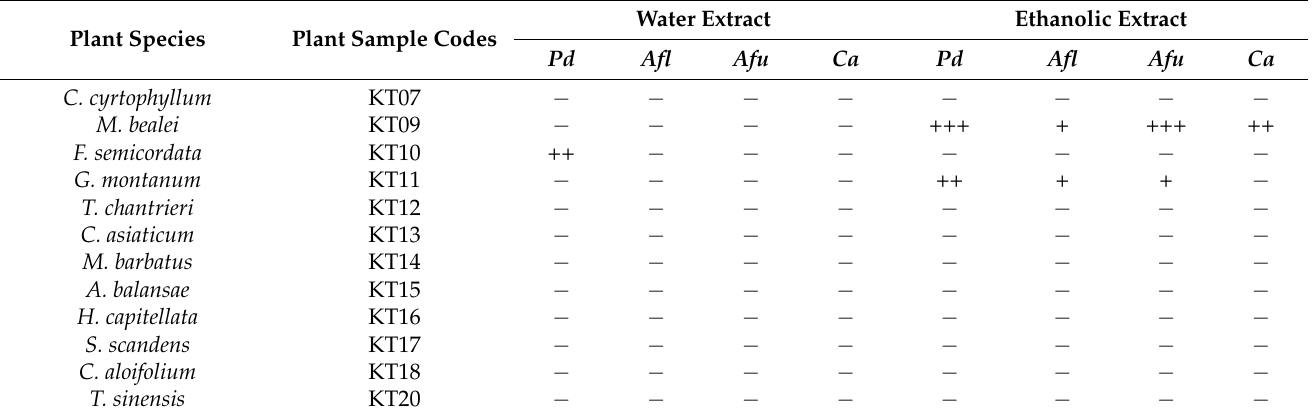
Table 2. Antifungal activity of the plant crude